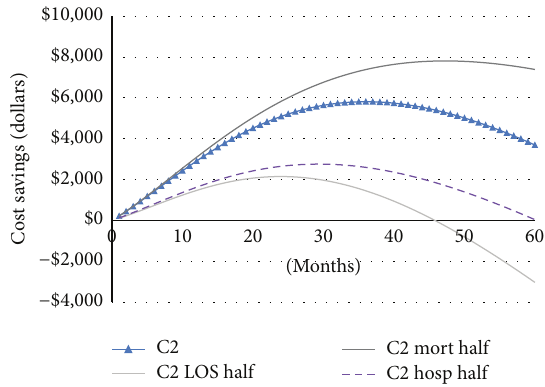
Figure 5: Sensitivity analysis of cost saving curve for cohort